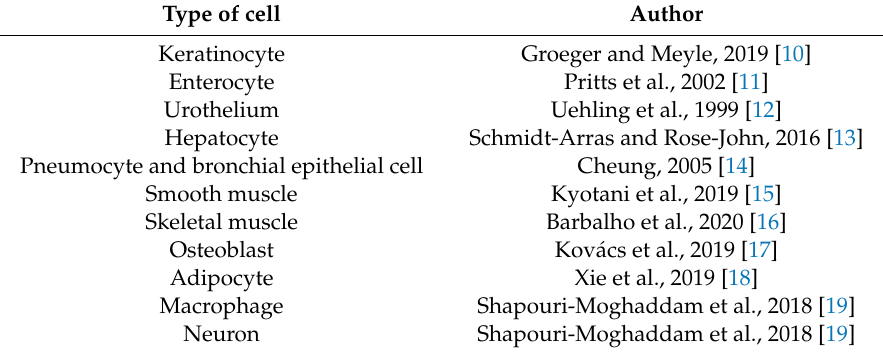
Table 2. Examples of cells producing